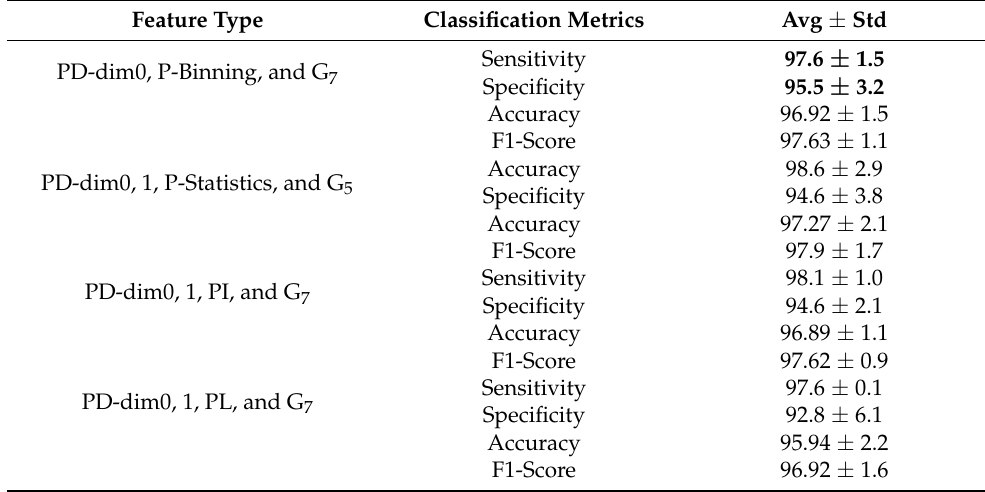
Table 2. The top performing ULBP geometries and all PD vectorizations for Mini-MIAS.